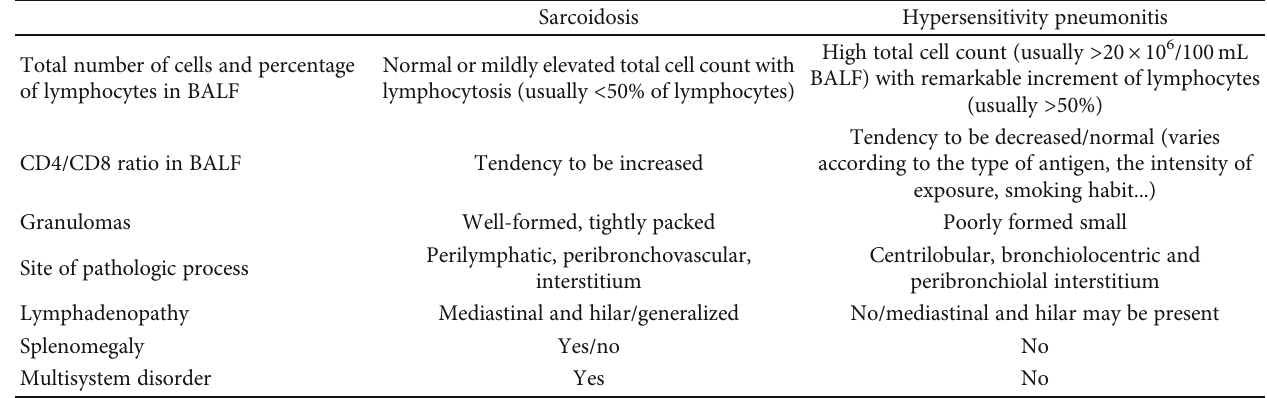
Table 1: Di ff erences in immunological features between sarcoidosis and HP.